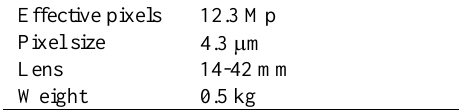
Table 2. Technical specification of the onboard camera